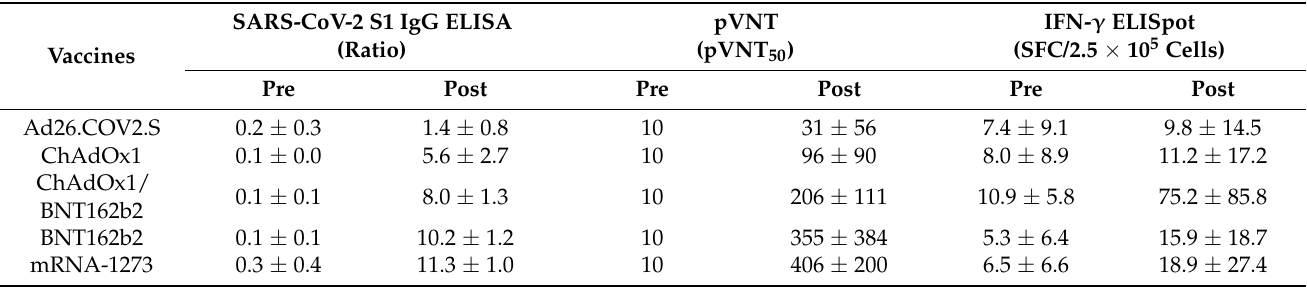
Figure 3. Pre- and post-vaccination humoral and cellular immunities of SARS-CoV-2-naïve partici- pants. ( a ) SARS-CoV-2 S1 IgG ELISA; ( b ) pVNT 50 titer; ( c ) IFN- γ ELISpot count. Wilcoxon matched- pairs signed-rank test was used to compare differences between each pre- and post-vaccination. The blue dashed line indicates the cutoff (S1-IgG = 0.8 for negative and 1.1 for positive, pVNT 50 = 10). Kruskal–Wallis test by Dunn’s multiple comparisons test was used to compare differences between the vaccine groups. ns, p > 0.05, * p < 0.05, ** p < 0.01, *** p < 0.001, **** p < 0.0001. Table 5. The pre- and post-vaccination humoral and cellular immune responses in SARS-CoV-2- naïve